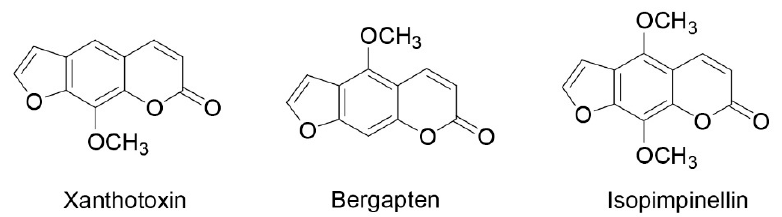
Figure 1. Structure of identified furanocoumarins.